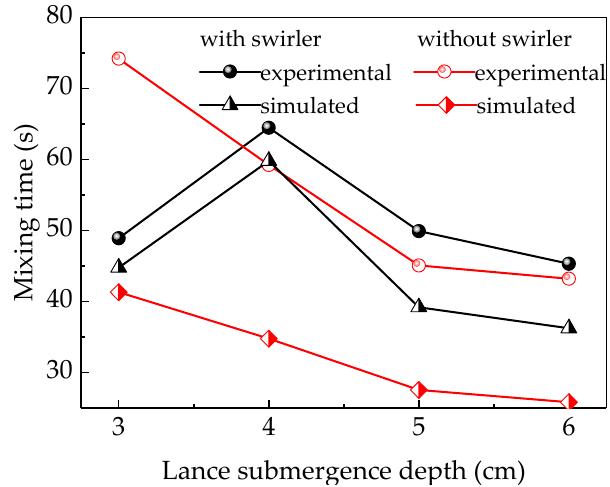
Figure 6. Comparison between the mixing times estimated experimentally and using simulations.